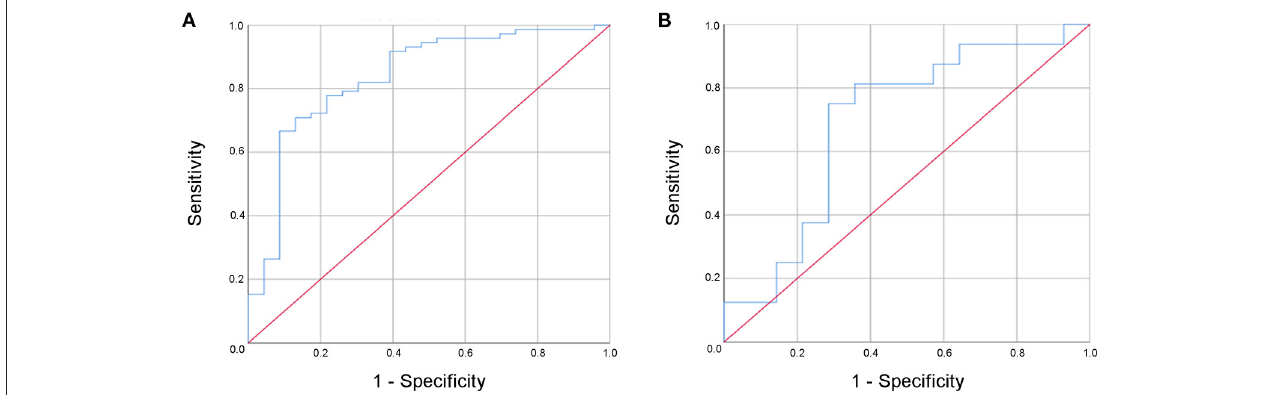
FIGURE 3 | Receiver operated curve (ROC) analysis of the multi-modal biomarker panel for the differentiation between minor ischemic stroke and transient ischemic attack for all patients (A) and for patients with complete recovery upon admission to the stroke unit (B) . specificity of 71.4% (AUC 0.69, 95% confidence interval 0.49– 0.89) for the differentiation between MIS ( n = 16) and TIA ( n = 14) ( Figure 3B ).